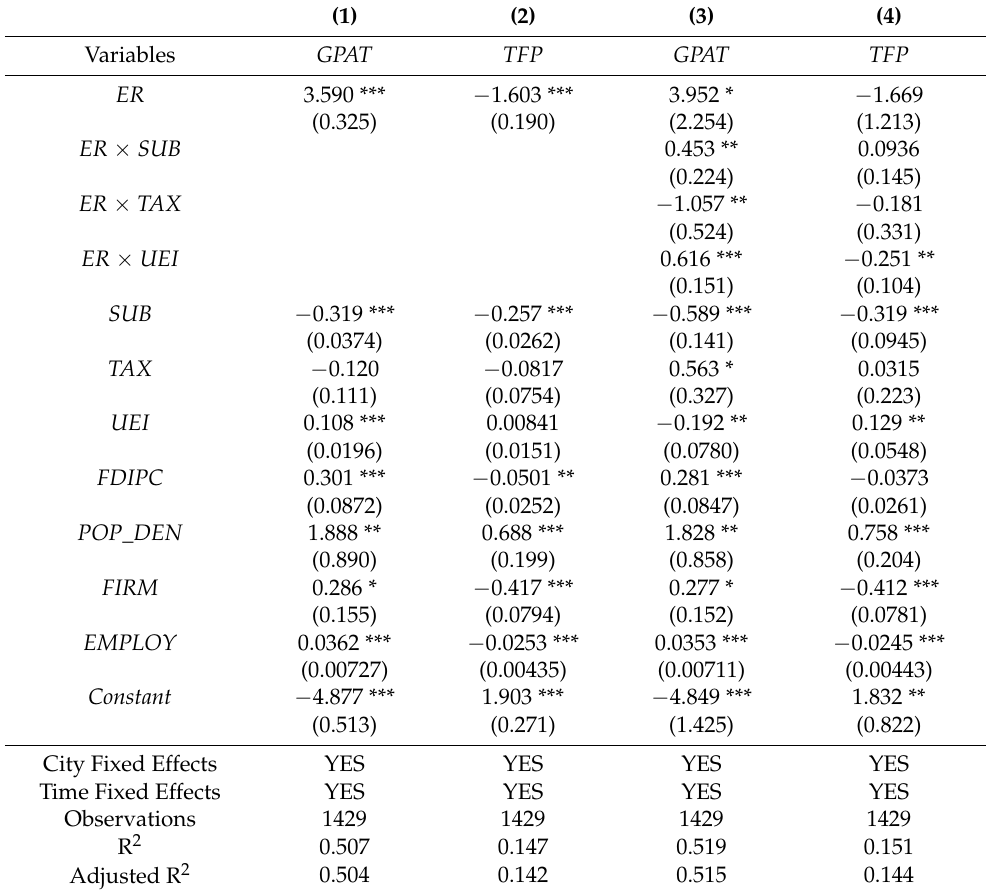
Table 2. Panel regression results for green innovation and